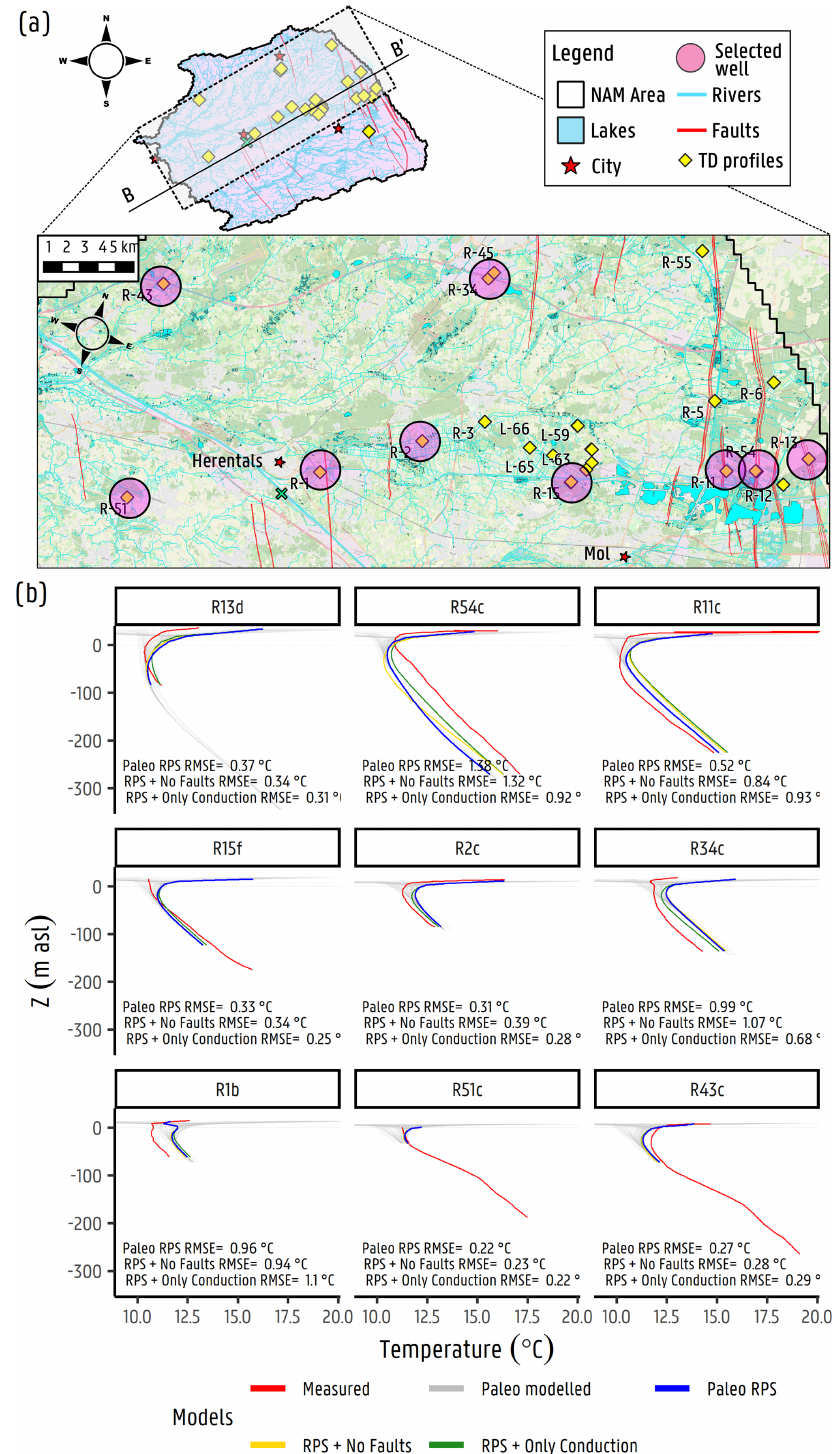
Figure 8. (a) Map showing selected TD profile borehole locations (magenta circles) along the approximate flow direction for R-13d, R-54c, R-11c, R15f, R-2c, R34c, R-1b, R51c, and R-43c. The background map source: © OpenStreetMap contributors, 2020. Distributed under the Open Data Commons Open Database License (ODbL) v1.0. (b) Temperature–depth profiles of selected boreholes and their filters (in lowercase letters) showing simulated values for the paleo-temperature model (baseline) and for simulation cases 2 and 3 (only thermal conduction and without faults, respectively). Modelled TD profiles for every time step of the baseline case are also included (in grey, paleo